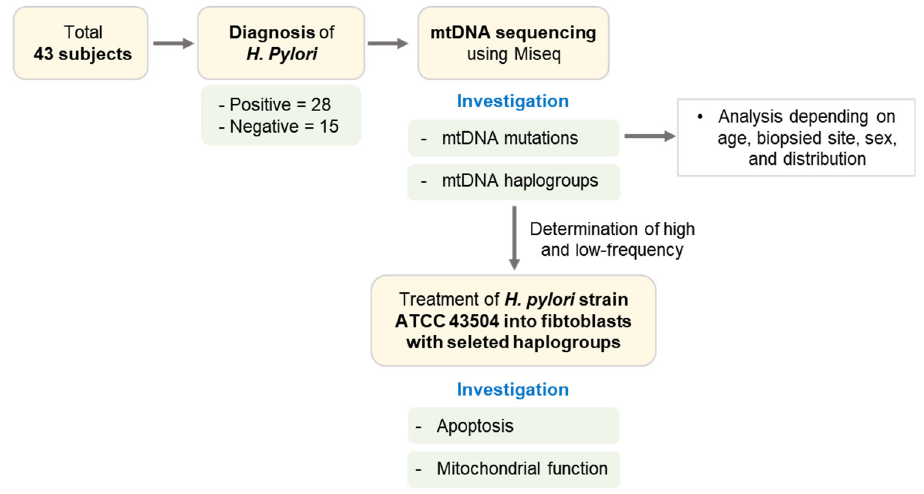
Figure 1. Experimental design of study. A total of 43 subjects, H. pylori -positive ( n = 28), -negative population ( n = 15), were investigated for mtDNA mutations and haplogroups. High- and low-frequency haplogroups in H. Pylori -positive population were determined, and fibroblasts with selected haplogroups were infected with H. Pylori strain ATCC 43504. Apoptosis and mitochondrial function were investigated in infected fibroblasts with selected haplogroups. mtDNA mutations were analyzed depending on age, biopsied site, sex, and distribution on mDNA location. Table 1. Information on study subjects.